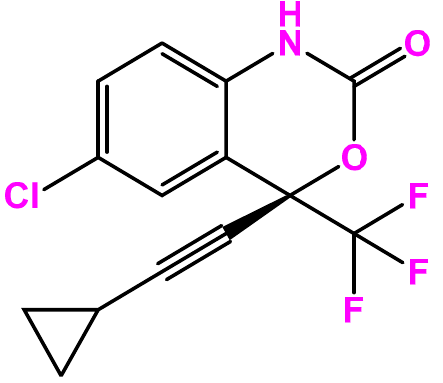
Figure 1. Efavirenz chemical structure.